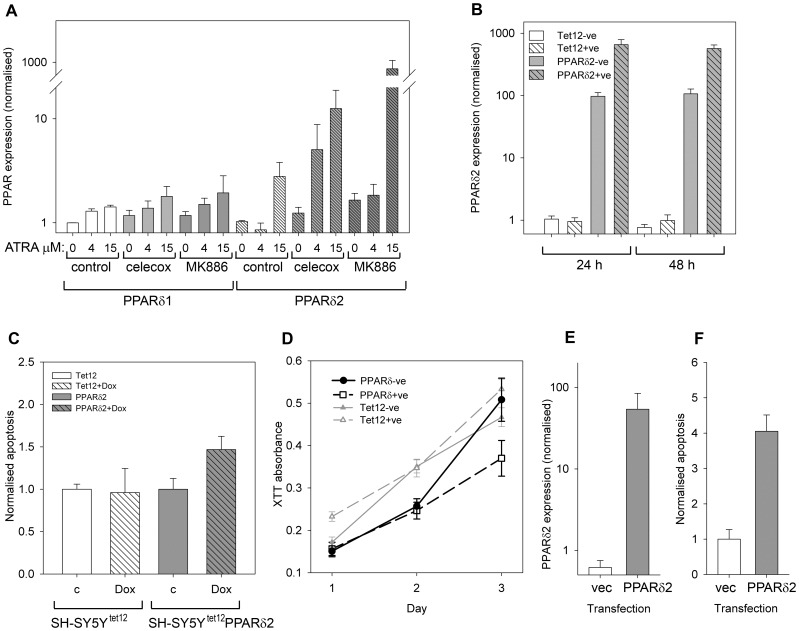
Expression of PPARδ isoforms after 5-LO inhibition and treatment.(A) PPARδ1 and PPARδ2 (bars with diagonal lines) mRNA expression after treatment with 0, 4 µM or 15 µM ATRA in the presence of control vehicle (no shading), 22 µM celecoxib (light grey shading) or 1 µM MK886 (dark grey shading). PPARδ1 mRNA expression increased with ATRA treatment (ANOVA, P = 0.03); PPARδ2 mRNA expression increased significantly after treatment with celecoxib with ATRA or MK886 with ATRA (ANOVA, P = 0.033). (B) Expression of PPARδ2 transcripts in SH-SY5Ytet12PPARδ2 cells treated with doxycycline (referred to as PPARδ2+ve cells; grey bars, diagonal lines) and without doxycycline (referred to as PPARδ2-ve cells; grey bars; no diagonal lines). Parental cells (SH-SY5Ytet12 or Tet12 in the legend) are also shown with (+ve, white bars with diagonal lines) and without (−ve; white bars) doxycycline treatment. (C) Apoptosis determined using flow cytometry in PPARδ2-ve and PPARδ2+ve cells after 48 h compared to control SH-SY5Ytet12 cells with (Dox; Tet12+ve) and without (c; Tet12-ve) doxycycline. Three experiments, 2–3 replicates per experiment; data were normalised to the mean control (without doxycycline) per experiment for each cell line. Up-regulation of PPARδ2 expression with doxycycline significantly increased apoptosis of SH-SY5Ytet12PPARδ2 cells (Welch’s t test on all normalised values t13.4 = 2.3, P = 0.037), but there was no effect on SH-SY5Ytet12 cells (t7.6 = −0.14, P>0.8). Overall levels of apoptosis (not normalised) increased from a mean of 22.5% in SY5Ytet12PPARδ2 cells without doxycycline to 32.3% in cells after induction of PPARδ2. Despite the leaky expression of PPARδ2 in SH-SY5Ytet12PPARδ2 cells without doxycycline, levels of apoptosis were not significantly higher than in the parental SH-SY5Ytet12 cells (P>0.4). (D) Viability, measured by XTT assays for the PPARδ2-ve (•, solid line) cells (no doxycycline), PPARδ2+ve cells (doxycycline; □, dashed line), Tet12-ve (no doxycycline; ▴, solid grey line) and Tet12+ve cells (doxycycline; Δ, dashed grey line) over 48 h. (E) Normalised expression of PPARδ2 transcripts in SH-SY5Y cells after transient transfection with the empty pcDNA4/TO vector (vec; white bars) or pcDNA4/TO PPARδ2 (PPARδ2; grey bars). Cells transfected with pcDNA4/TO PPARδ2 had significantly higher expression of PPARδ2 mRNA 48 h after transfection than the control cells transfected with empty pcDNA4/TO vector (Mann Whitney U, P>0.001). (F) Apoptosis, shown normalised to the mean vector control in each of three experiments (3–5 replicates per experiment) in SH-SY5Y cells 72 h after transient transfection with the empty pcDNA4/TO vector (vec; white bars) or pcDNA4/TO PPARδ2 (PPARδ2; grey bars).Mean apoptosis (38.8%) in cells transfected with pcDNA4/TO PPARδ2 was significantly higher than the vector-transfected controls (13.8%; t-test, P<0.05). All error bars are±SEM.